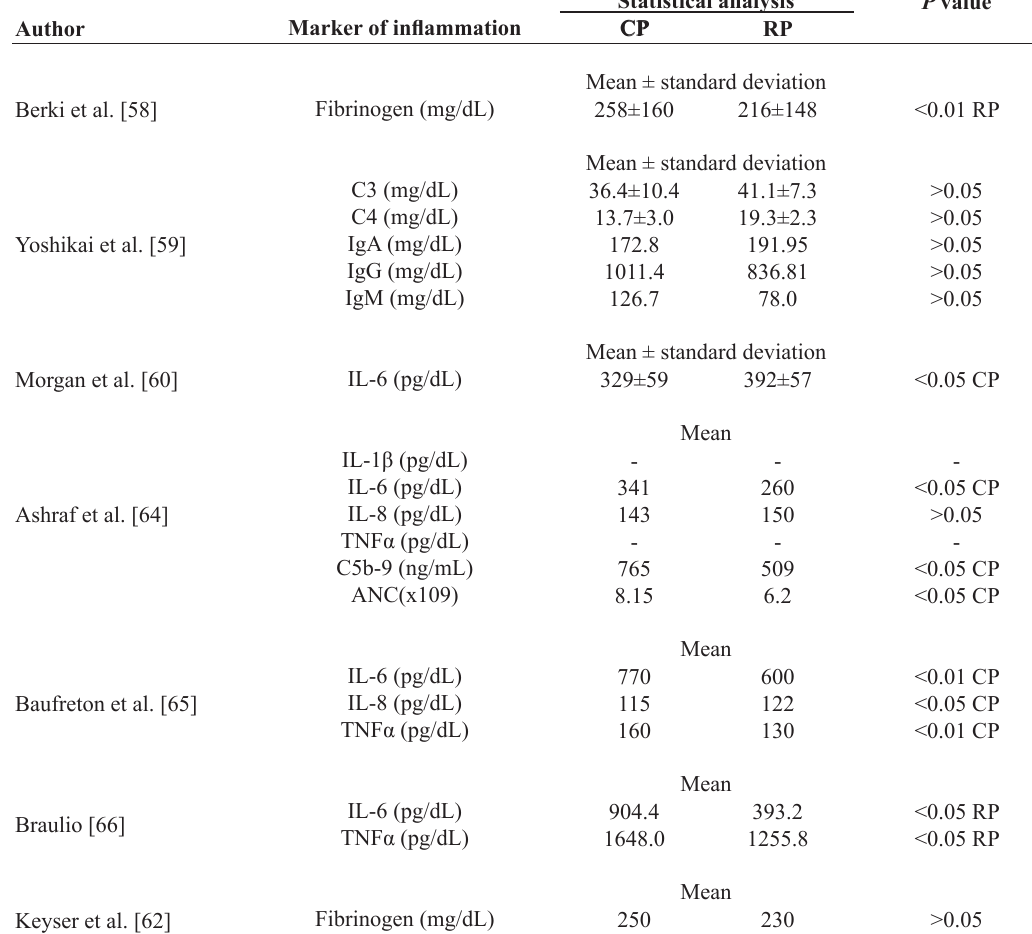
Table 2. Comparative analyses of roller vs. centrifugal pumps for cardiopulmonary bypass, using markers of inflammatory response as outcome